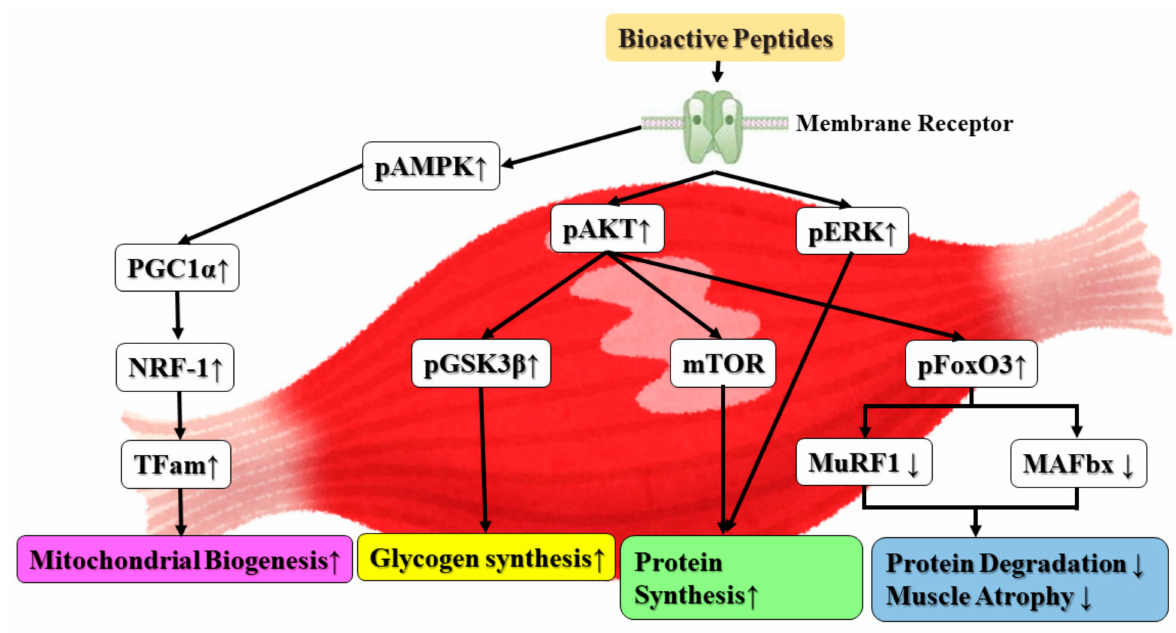
Figure 8. Bioactive peptides enhance myogenic differentiation and skeletal muscle protein synthesis under high-glucose conditions in C2C12 myoblast cells. ↑ increase, ↓